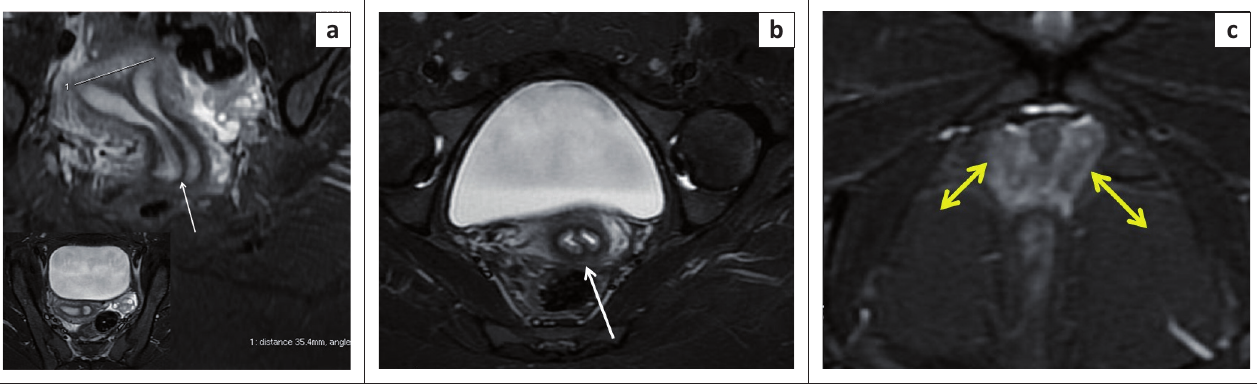
FIGURE 10: Coronal oblique T2 sequence demonstrates a complete septate uterus. The outer fundal contour is flat. The intercornual distance is 3.5 cm. Internal indentation of the muscular and fibrous component is seen in fundal region (a) and there is only a fibrous component in the lower part (white arrow) (b), extending down to the cervix and two vaginal cavities (c – yellow double-headed